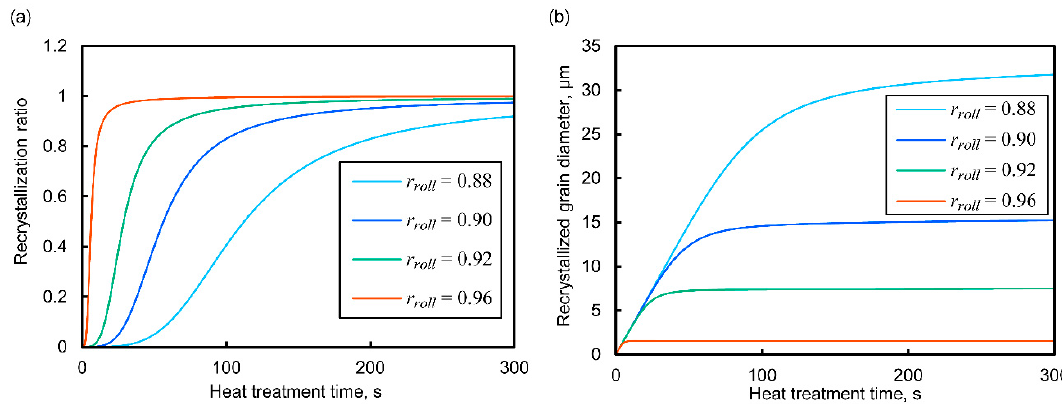
Figure 17. Variation of ( a ) recrystallization ratio and ( b ) recrystallized grain size with respect to thickness reduction of plate rolling during heat treatment at 600 °C.